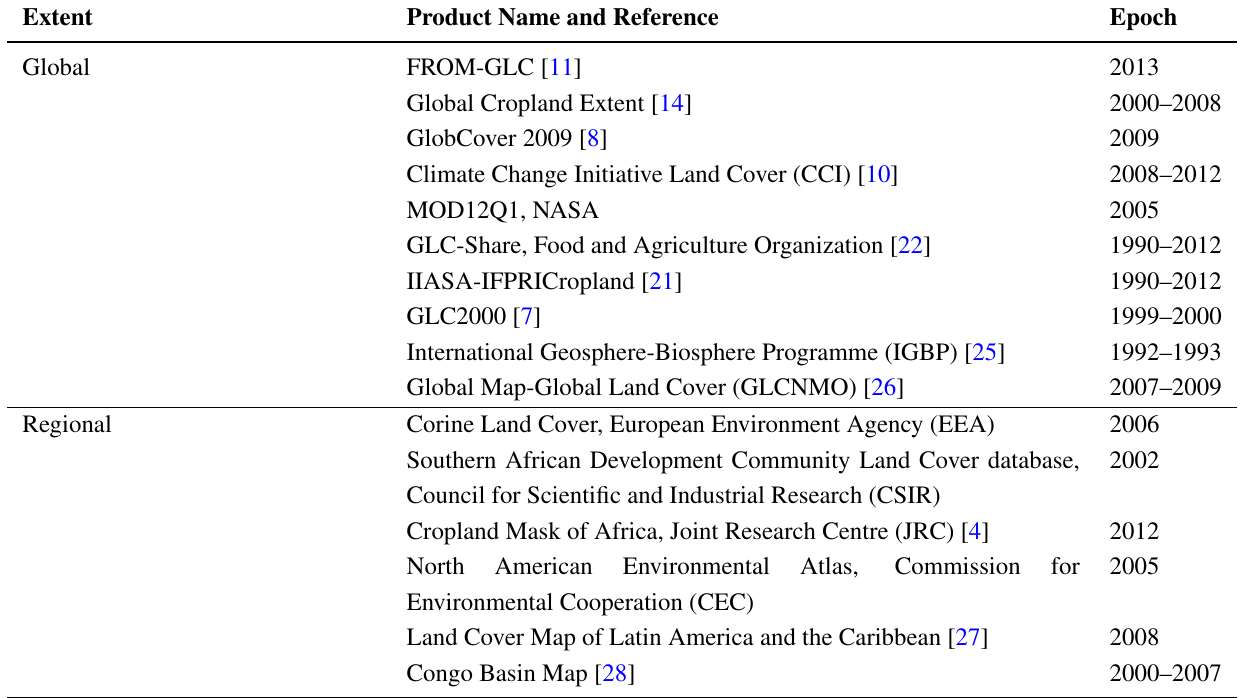
Table 1. Input maps for the analysis. The first and second columns detail the extent and references of the considered product. The last column provides the reference year of the product or its time